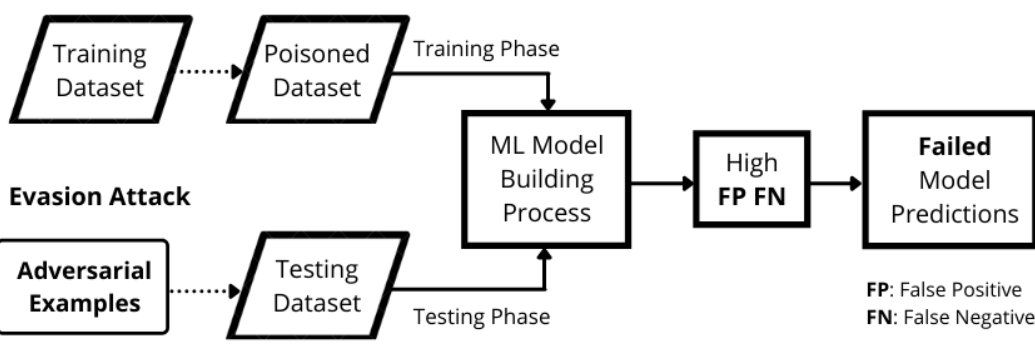
Figure 1. An illustration of poisoning and evasion attacks